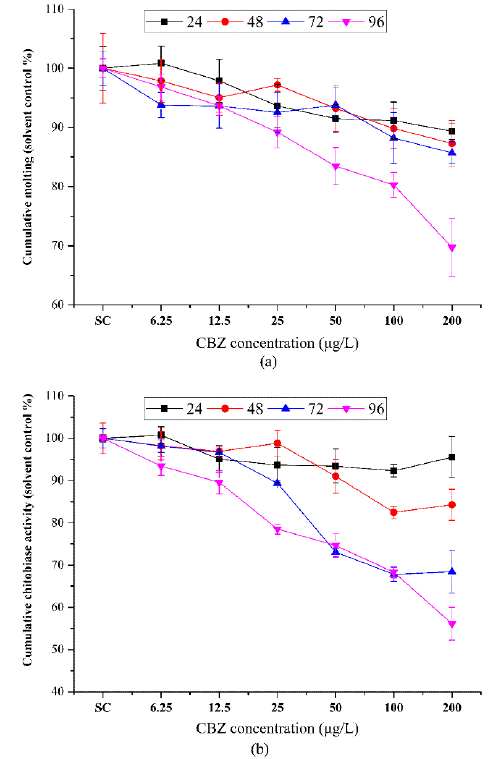
Figure 2. Effects of carbamazepine on cumulative molting ( a ) and chitobiase release ( b ) in juvenile Daphnia similis during acute exposure. Results are presented as mean ± SEM , n = 3 (10 individuals in each replicate).